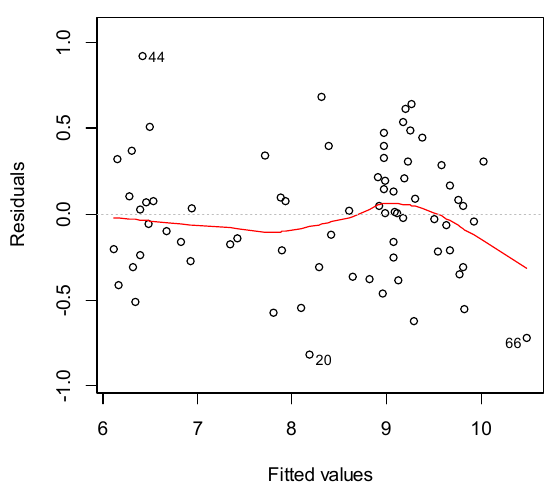
Figure 2. QQ-plot for the obtained model: total AOX.